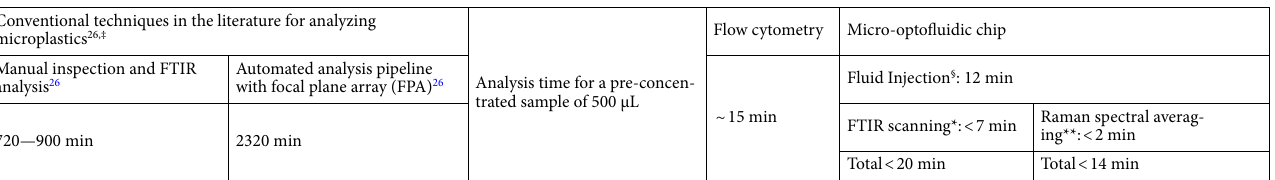
Table 1. A comparison of microplastics analysis time using different techniques. ‡ The study performed in this reference 26 was on a marine sediment but the spectroscopic analysis process is identical and appropriate for drinking water samples after sample preparation steps. § The microfluidic chip is first filled with the pre- concentrated sample of a 500 μL at a flow rate of nearly 42 μL/min, corresponding to the injection time is less than 12 min. *For a typical chip whose unit reservoir size is 300 μm wide and 1 mm long, the total area of 20 reservoirs, each for different particle sizes, is 6 mm 2 , which is 2 orders of magnitude smaller than the area of a standard filter of diameter 25.4 mm, hence if the latter requires 10 h for scanning, then our set of micro- reservoirs can be scanned in less than 7 min. **Assuming a relatively long averaging time for excellent signal (5 s per reservoir), and a 1 mm 2 laser spot, then the total should be less than 2 min (20 reservoirs with 5 s each = 100 s or 1.67